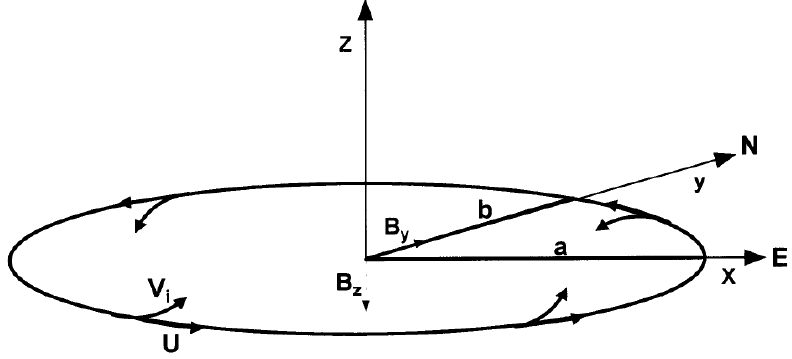
Fig. 2. An ellipse with large eccentricity used in the present model as representative of a planetary wave vortex of cyclonic winds. In E-region, the ions move with the wind but also are subject to U × B Lorentz forces. Also shown here is the local orthogonal coordinate system used in the